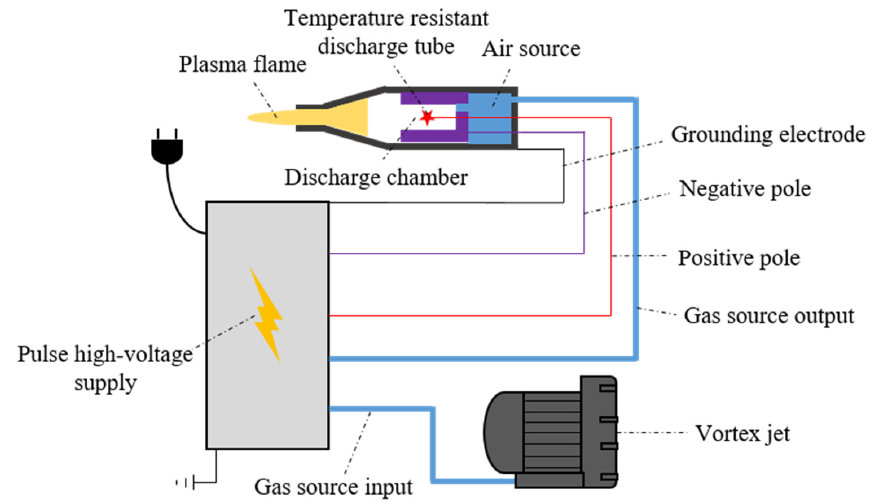
Figure 4. Schematic diagram of the working principle of “low-temperature plasma injection” equip- ment.